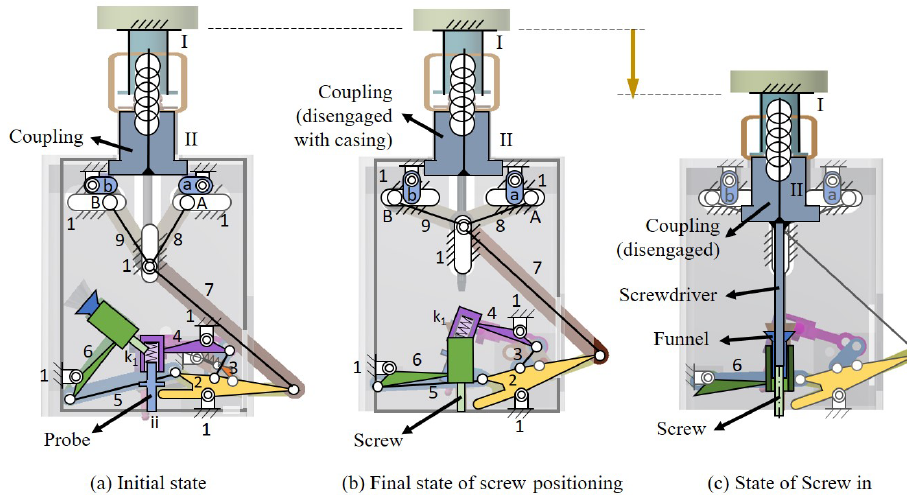
Figure 5. Mechanisms for the screw positioning, pin and stopper, and screw in.